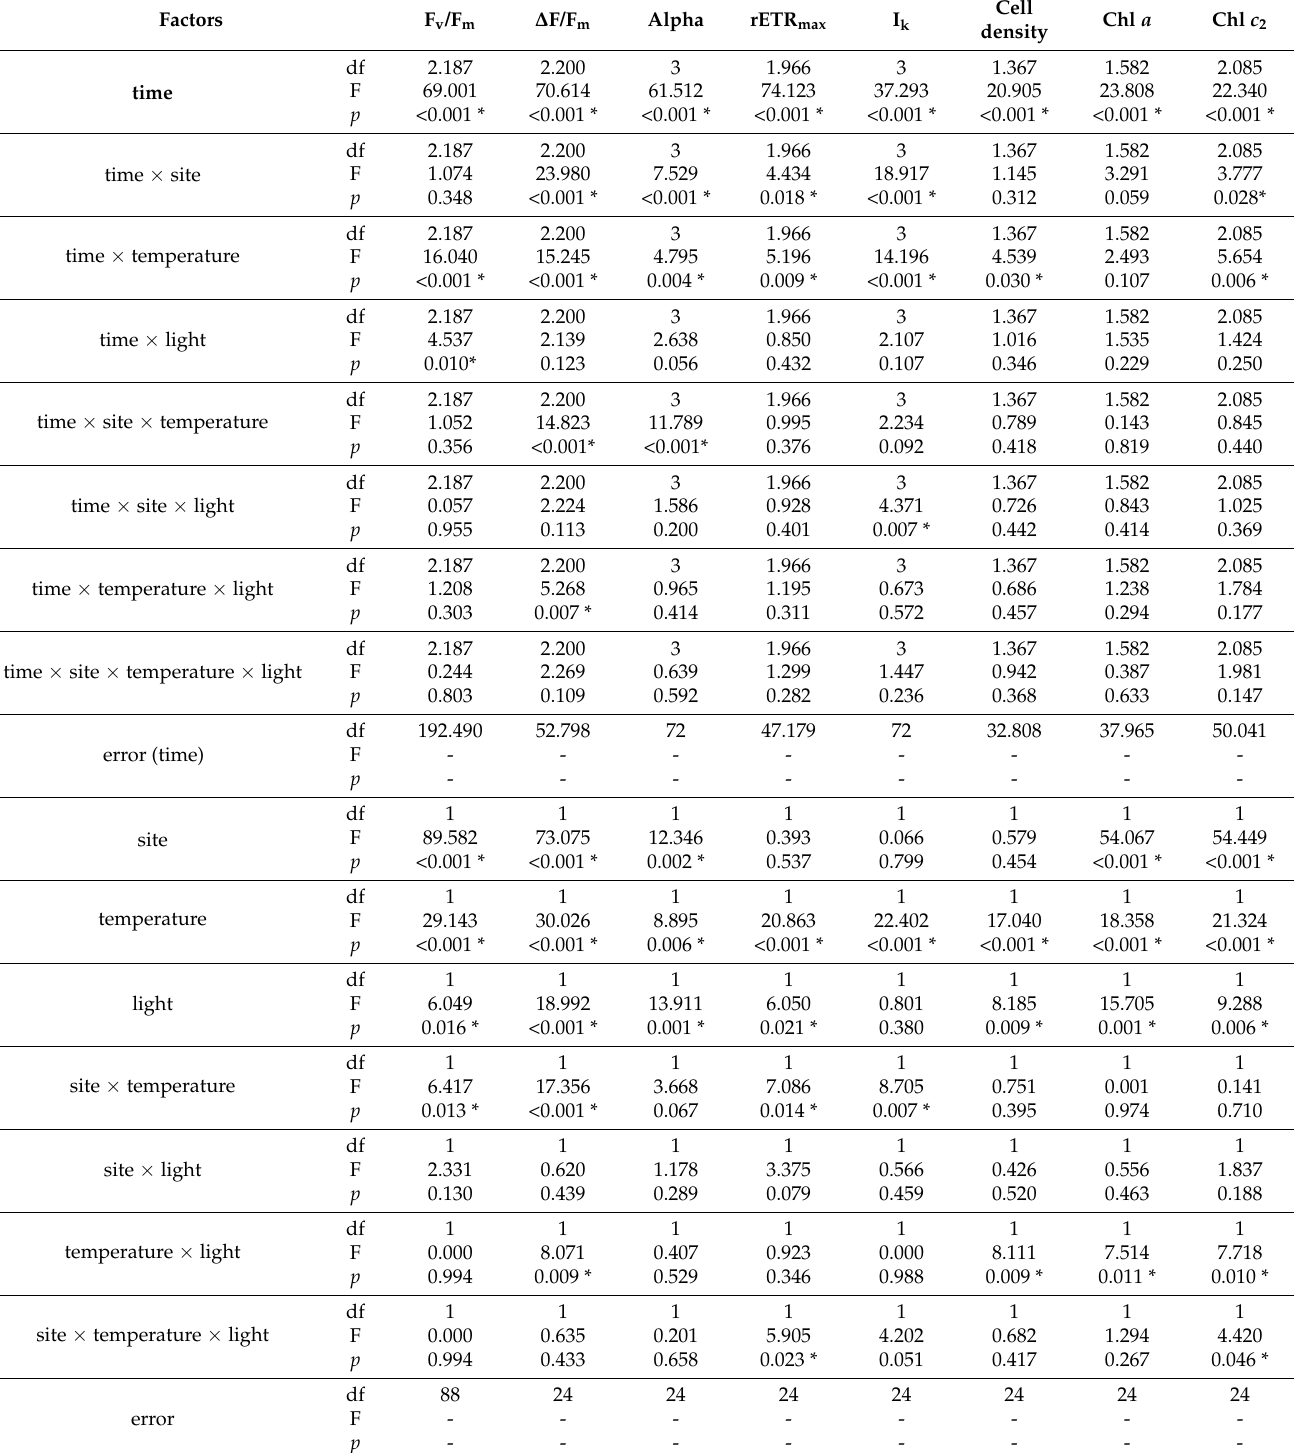
Table 2. Statistical indices of maximum quantum yield (F v /F m ), photosynthetic efficiency ( ∆ F/F m ), RLC-derived parameters (alpha, rETR max , and I k ), cell density, and pigment contents (Chl a and Chl c 2 ) (four-way